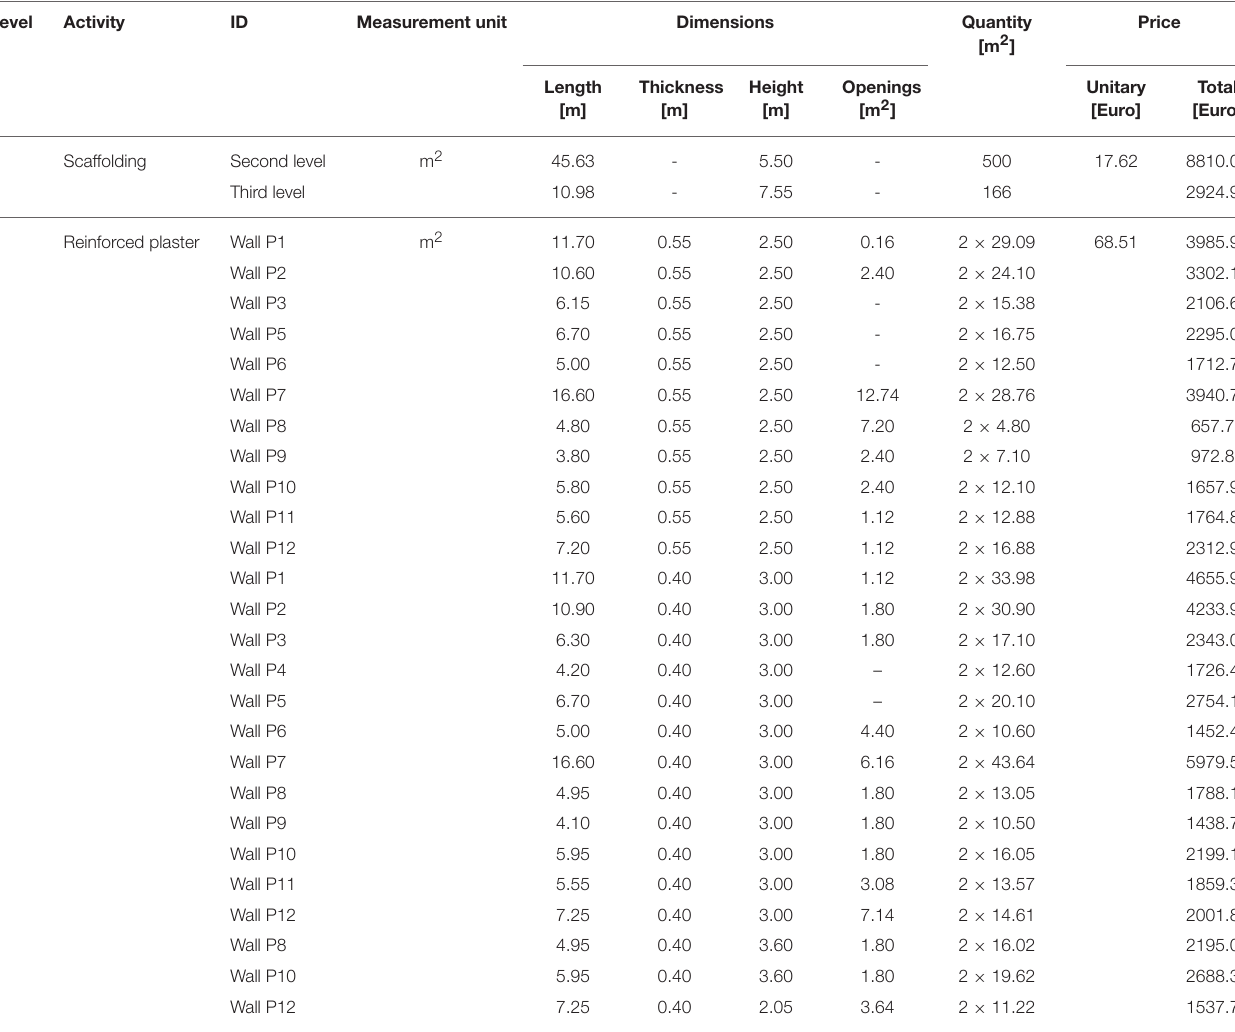
TABLE 5 | Seismic retrofitting interventions costs.